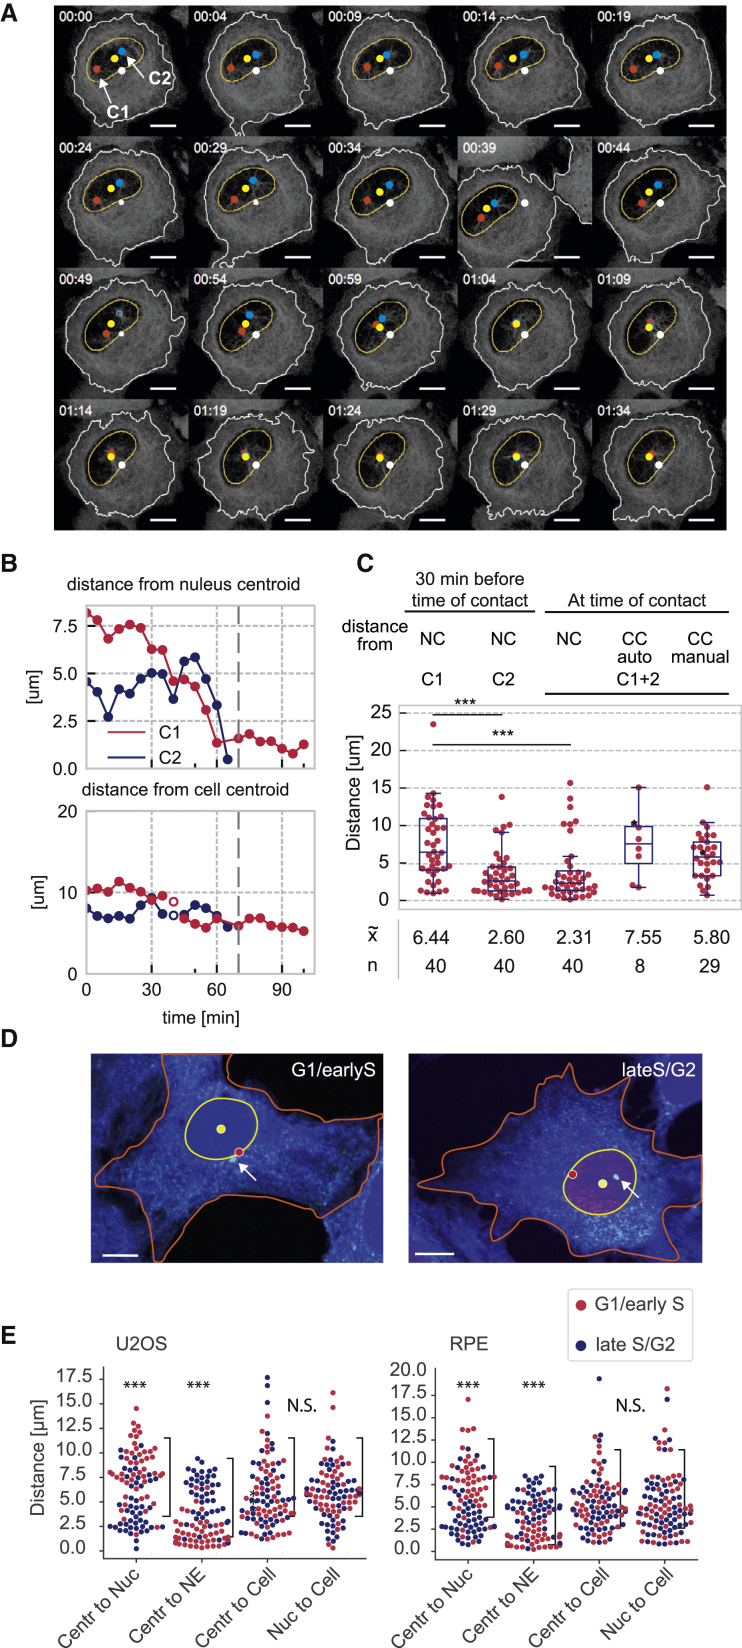
Centrosomes Congress toward the Nuclear Centroid(A) Automated tracking of centrosome position (see also Video S5). Still images describing the tracking of centrosome position using nuclear and cellular centroid as a reference. Nuclear and cellular masks were generated by automated image segmentation (see STAR Methods), the centroid was determined, and centrosome distance relative to nuclear and cellular centroid (yellow dot for nuclear and white dot for cellular centroid) was calculated using vector addition. Time is indicated in h:min on the top left; scale bar represents 10μm.(B) Quantification of tracking data. Centrosome tracks from the time-lapse experiment in (A) showing distance from nuclear and cellular centroid (μm) for centrosome 1 (C1, red) and centrosome 2 (C2, blue); dashed gray line indicates the time point when C1 and C2 make contact.(C) Data from population analysis. Distance from centroids 30 min before and at the time of contact was estimated as shown in (A) (nuclear centroid [NC], 32 tracks; cellular centroid [CC], 8 tracks). For cellular centroid estimation, automated segmentation was successful in only eight cells (due to problems with distinction from neighboring cells). Manual estimation of cellular centroid was performed at time of contact for 29 more tracks as indicated. p values were calculated using an independent two-sample t test. Levels of significance are indicated by stars (∗p < 0.05, ∗∗p < 0.01, ∗∗∗p < 0.001). The boxplot indicates median, first and third quartiles, and minimum/maximum values.(D) Analysis of nuclear positioning in U2OS cells by immunofluorescence. G2 cells were identified by CENPF staining (red), cell shape was visualized using CellTracker blue, and centrosomes were detected using gamma-tubulin staining (green). Nuclear mask and centrosomes were segmented in Python using the skimage library, while cell shape was estimated manually. Images show centrosome position in G1/early S (CENPF-negative) and late S/G2 (CENPF-positive) U2OS cells. The nuclear centroid is shown in yellow, and the cellular centroid is shown in red; centrosomes were stained using gamma-tubulin antibodies (green) and are indicated by arrow. The scale bar indicates 10 μm.(E) Quantification of centrosome position in U2OS and RPE cells. U2OS and RPE cells were analyzed as described in (D) and plotted grouping CENPF-negative (G1/early S) cells in red and CENPF-positive (late S/G2) cells in blue (three experiments, n = 50 per group and experiment). The data show distances (in μm) for centrosome to nuclear centroid, centrosome to NE, centrosome to cellular centroid, and nuclear centroid to cellular centroid. Significance for differences between the CENPF-positive and negative groups for each measurement was calculated using a two-sided t test.